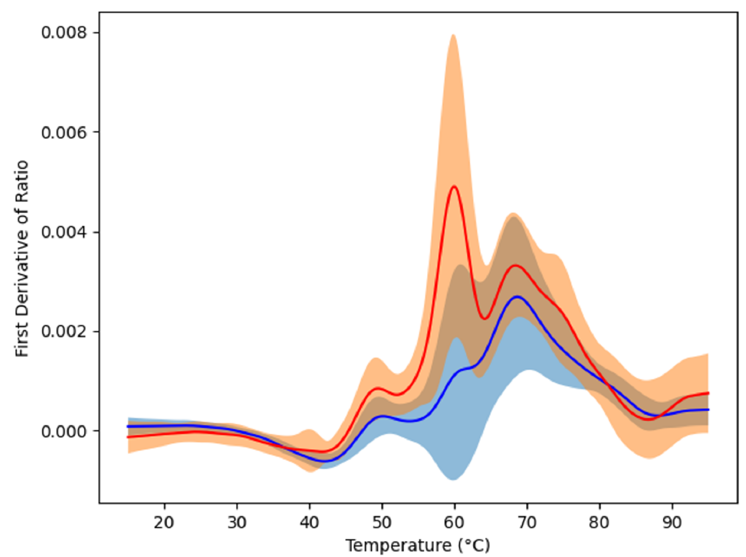
Figure 1. Means of the first derivatives of the ratio F330/F350. The red curve corresponds to glioma patients while the blue one is the one of the controls. The color regions graphically show the variability of the data by indicating the standard deviation.